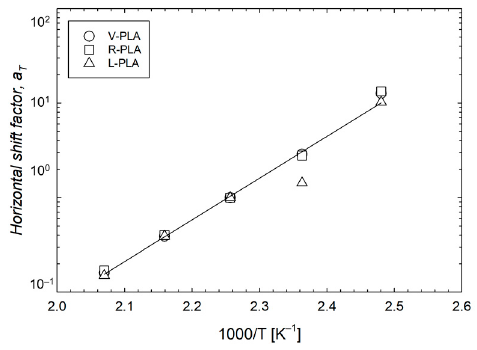
Figure 5. Horizontal shift factors vs. temperature.